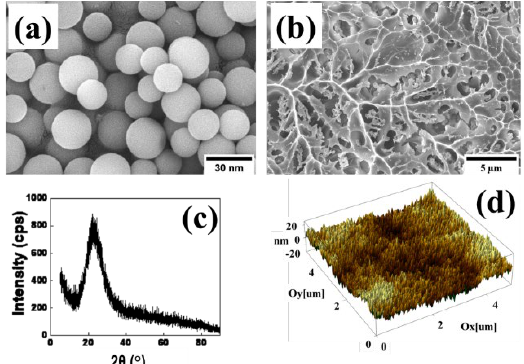
Figure 4. SiO 2 NPs ( a ) SEM and ( c ) XRD; and SiO 2 /TMCS coatings ( b ) SEM and ( d ) AFM.